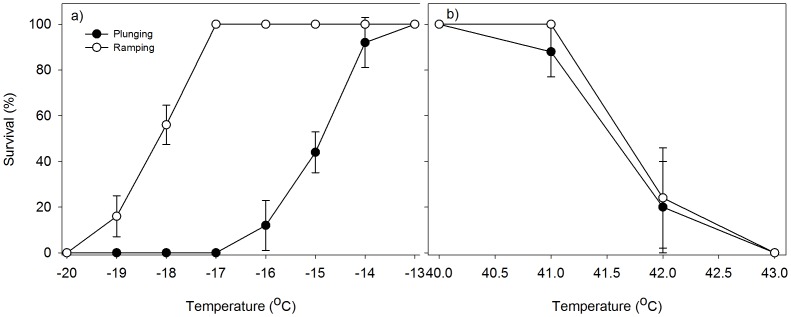
Mean survival (%) of DBM (P. xylostella) exposed to plunging and two-way ramping (a) cold temperatures and (b) hot temperatures.